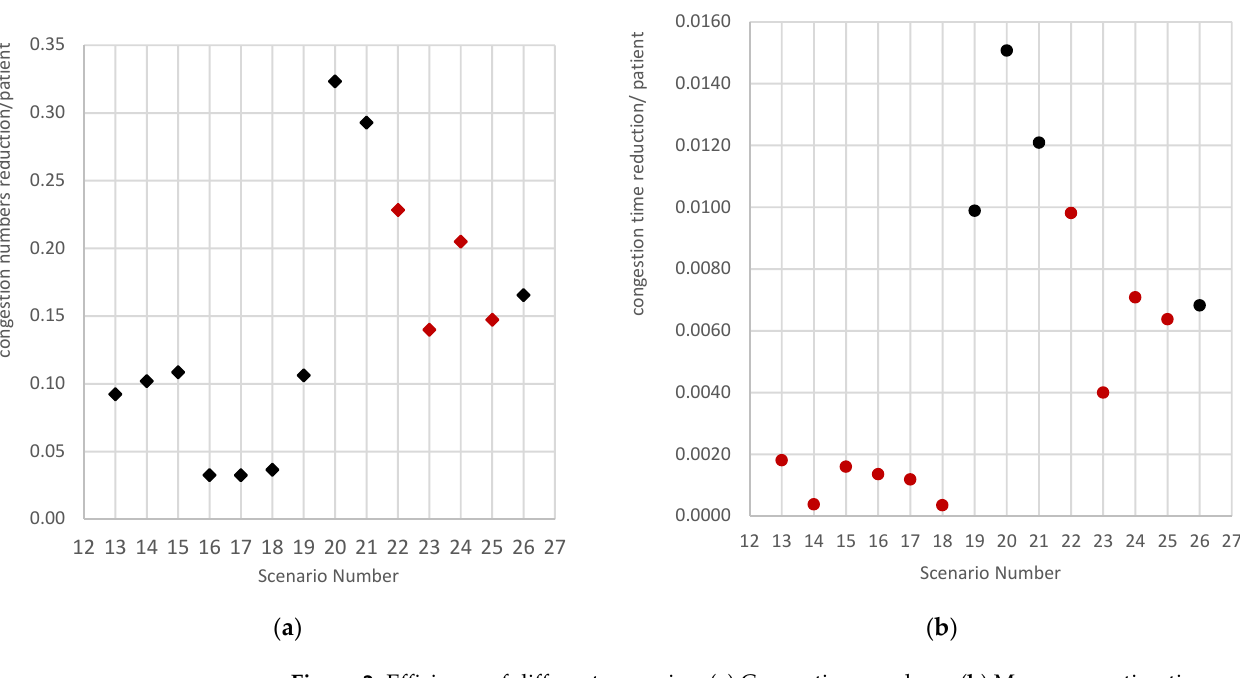
Figure 2. Efficiency of different scenarios. ( a ) Congestion numbers. ( b ) Mean congestion time.